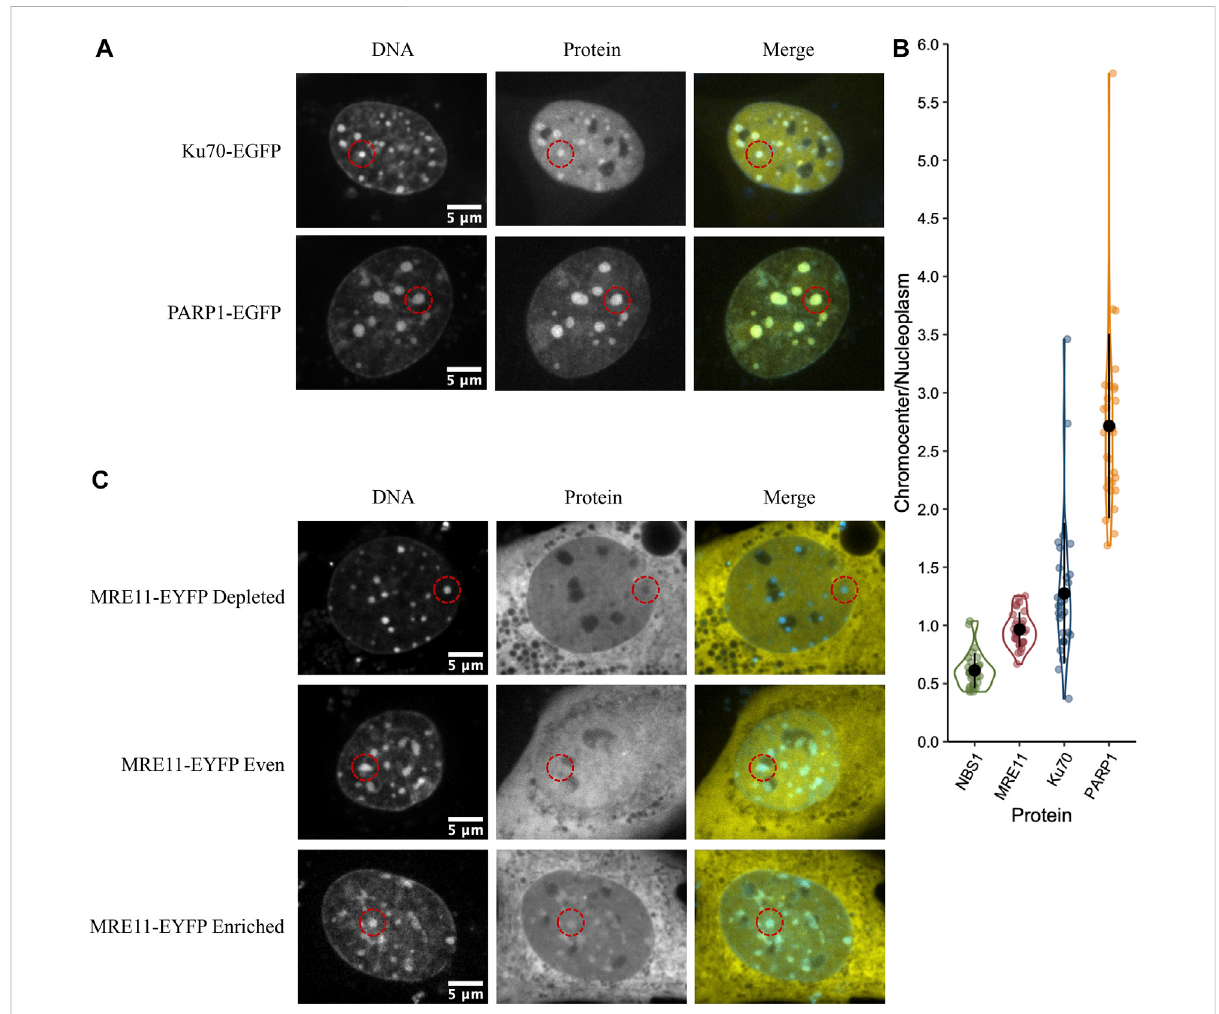
(A) CH3/10T1/2cellsweretransfectedwitheitherPARP1-EGFPorKu70-EGFPandstainedwithHoechst33342tovisualizeDNA. (B) Quanti fi cationof relative fl uorescent protein chromocenter intensity for proteins NBS1-EGFP, MRE11-YFP, Ku70-EGFP, and PARP1-EGFP ( n = 30 cells for each protein). (C) CH3/10T1/2cellsweretransfectedwithMRE11-YFPandstainedwithHoechst33342tovisualizeDNA.Depleted,homogenous,and enriched distributions of MRE11-YFP are